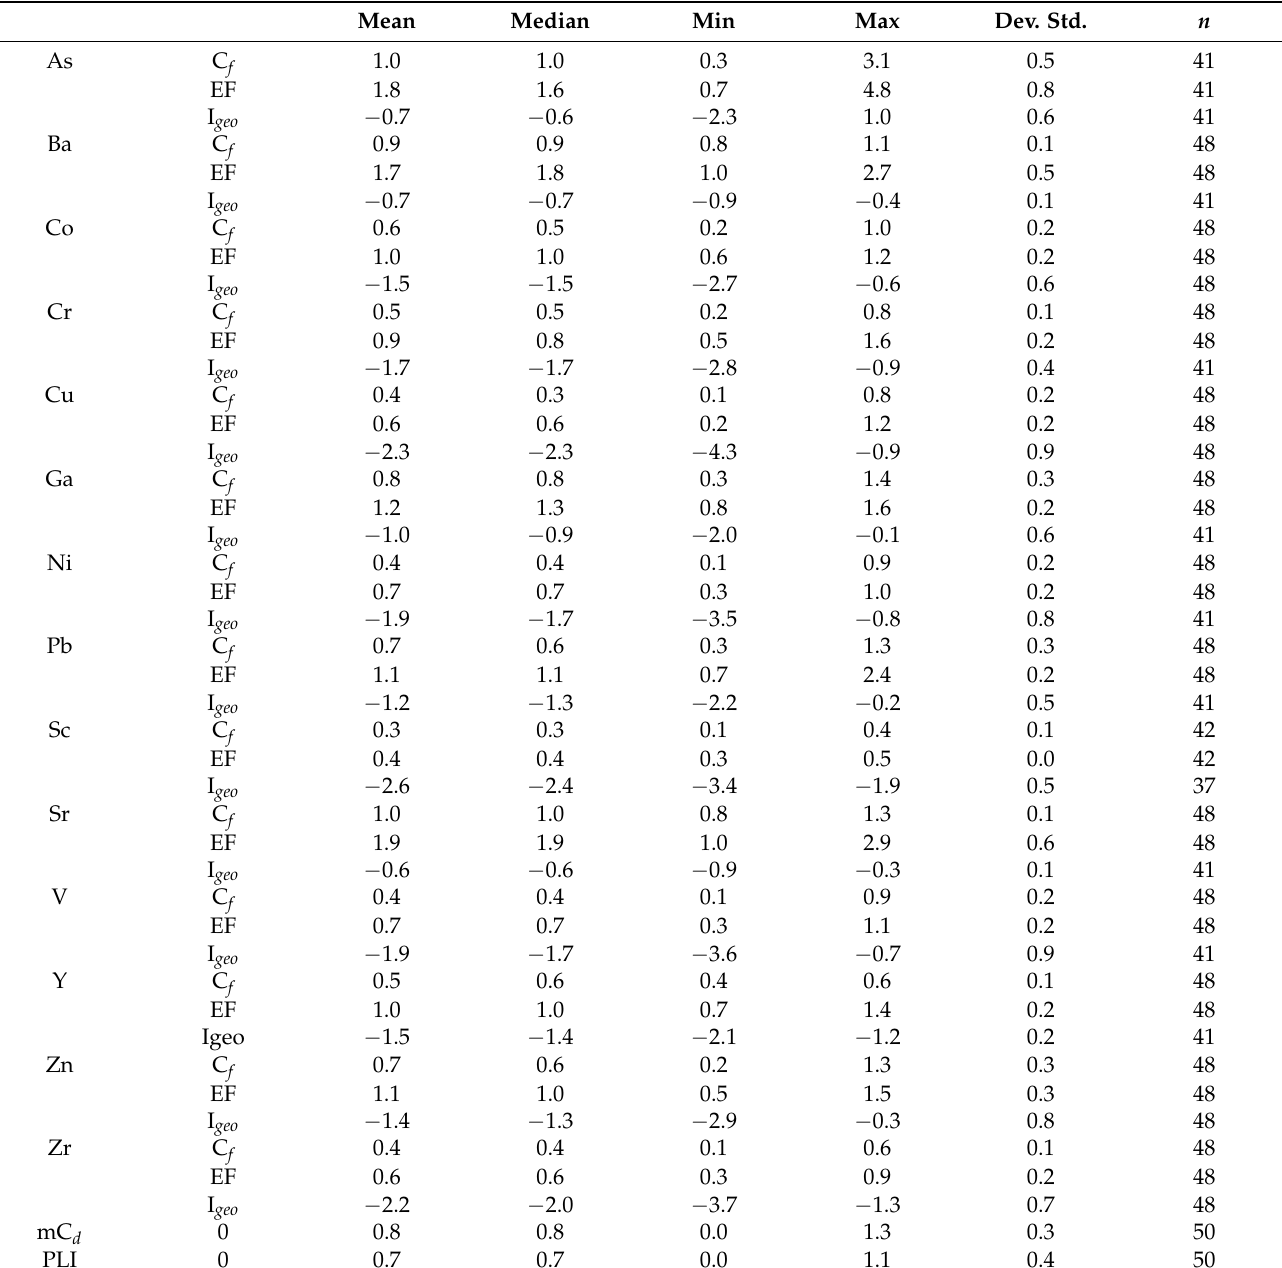
Table 4. Statistical values (mean, median, min, max and dev.st.) of the contamination indexes data and pollution indicators. Mean Median Min Max Dev. Std.